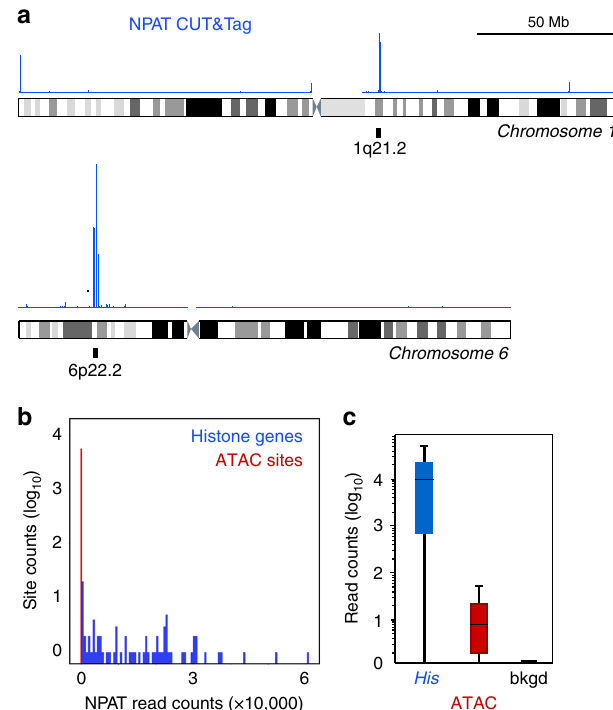
Fig. 4 CUT&Tag pro fi ling of the NPAT chromatin factor and chromatin accessibility. a Ideograms of chromosome 1 and chromosome 6 with the clusters of replication-dependent histone genes (6 genes at 1q21.2 and 55 genes at 6p22.2) indicated. An NPAT CUT&Tag pro fi ling track is displayed over each chromosome. The major NPAT peaks fall at the histone genes. b Distribution of read counts in CUT&Tag pro fi ling. Called accessible sites